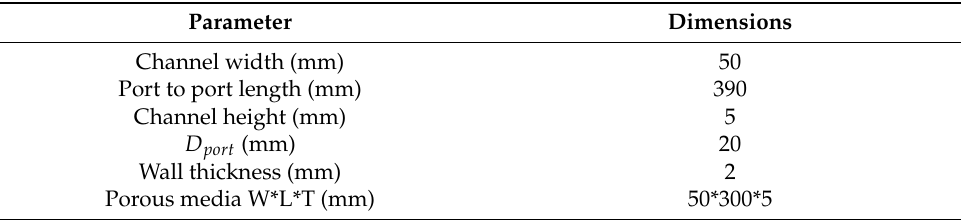
Table 2. Detailed dimensions of test module and metallic porous media.